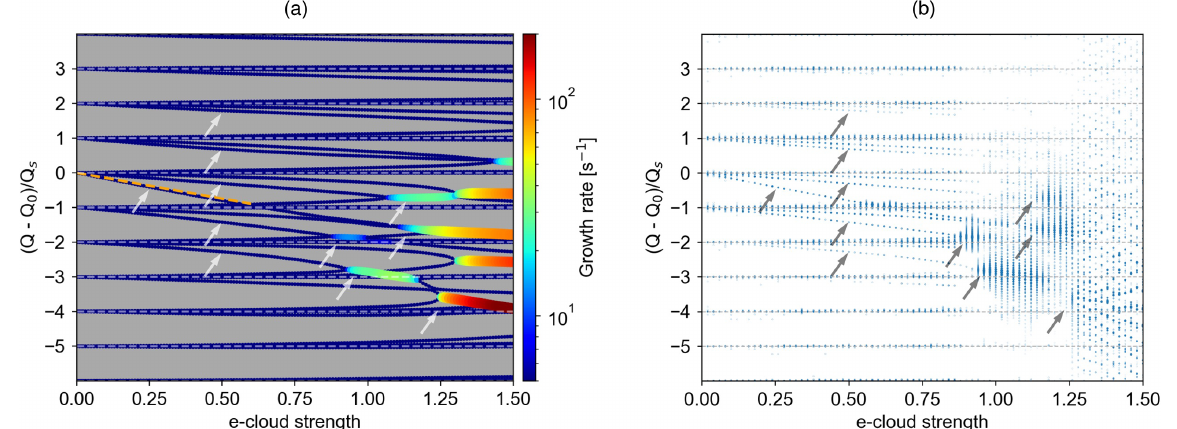
¼ Δ Q ¼ 0 (the color code is Φ R